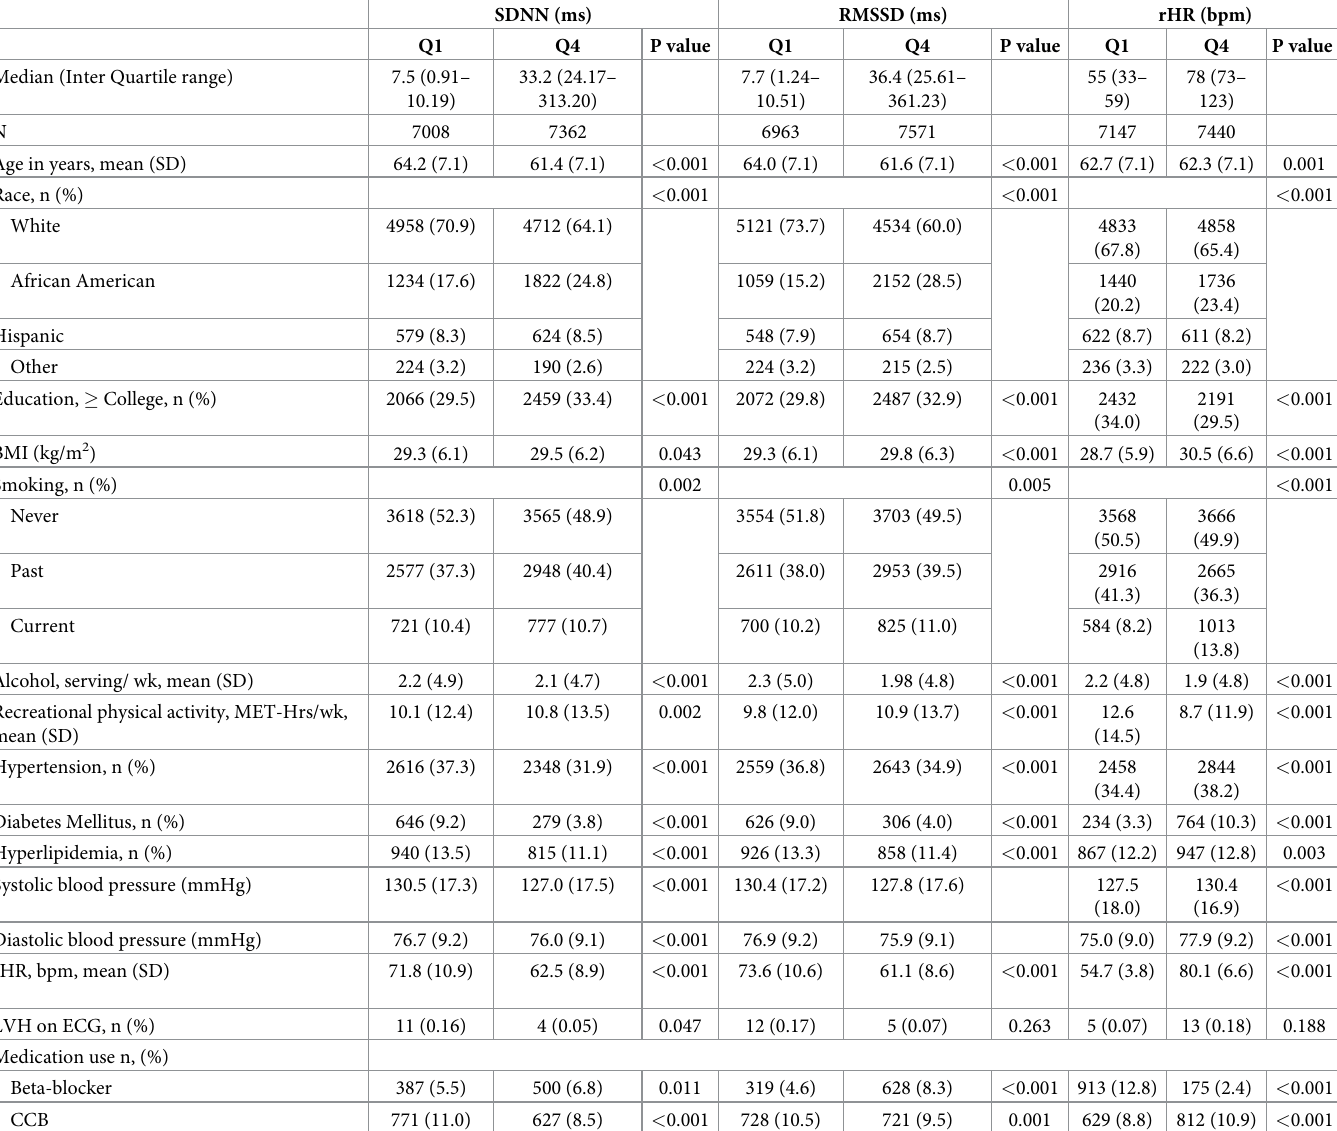
Table 1. Baseline characteristics of study participants according to quartiles of SDNN, RMSSD and